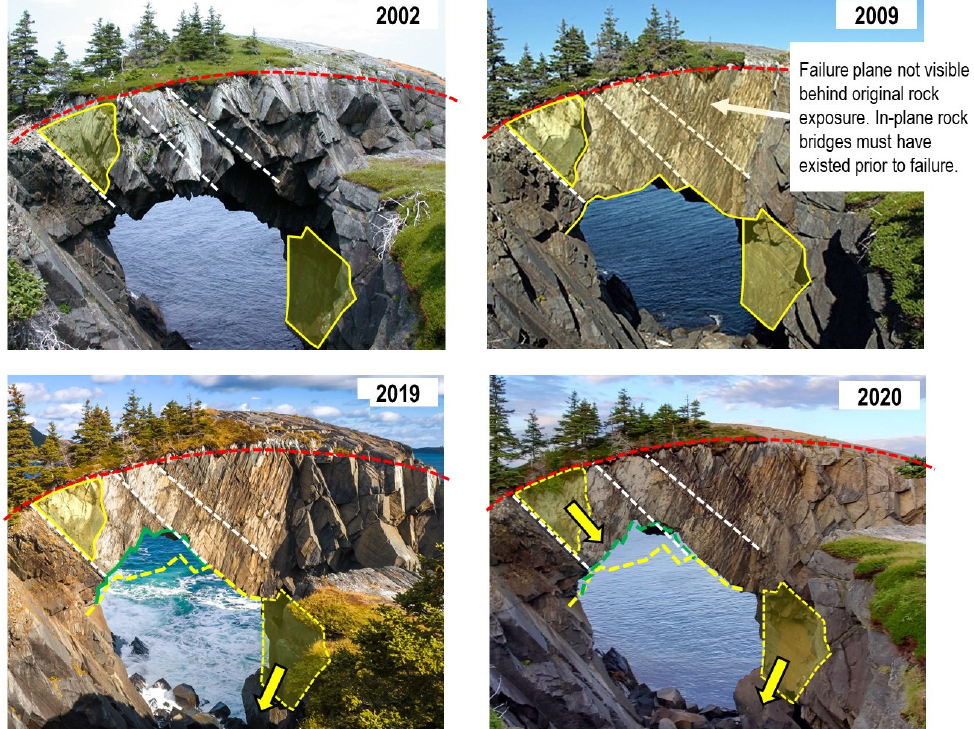
Figure 15. Evolution of Berry Head Arch (Newfoundland, Canada) from 2002 to 2020. Photos sourced from Google Images under a creative common license CC2.5.